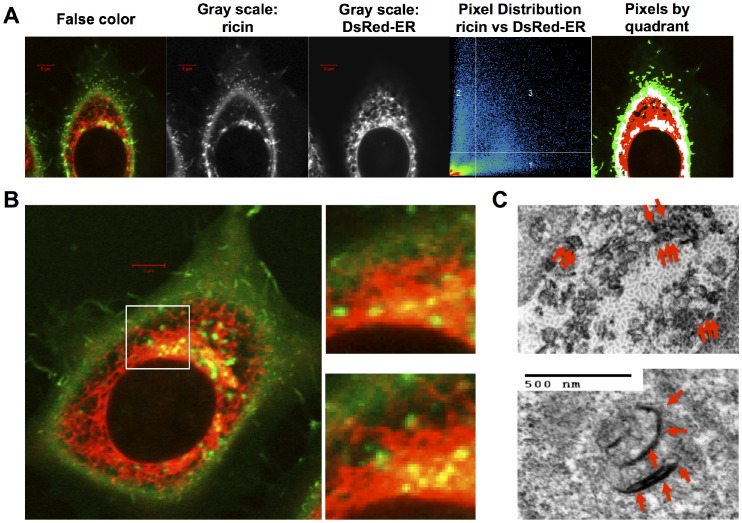
Localization of ricin in ER.In panel A five different views of the same image are shown, demonstrating the colocalization of ricin (green) and Ds-Red ER. The left panel shows a false color image of both markers, followed by two gray scale images showing the ricin and ER separately. The fluorescent intensity of each pixel is mapped in a 2-D dot-plot showing red on the vertical axis, and green on the horizontal axis. The right hand image maps the micrograph by quadrant of the pixel in the dot plot: pixels in quadrant one are green (ricin only), quadrant 2 are red (ER only), colocalized pixels are white (quadrant 3), pixels that fall below the threshold for both fluors are black. Panel B shows a false color confocal image, with a 10 µm×10 µm region marked. To the right are two vertical planes from that region, vertically separated by 0.7 µm. Colocalized pixels are yellow-orange. In panel C we show TEMs demonstrating HRP-ricin (red arrows) localized in the ER and Golgi.